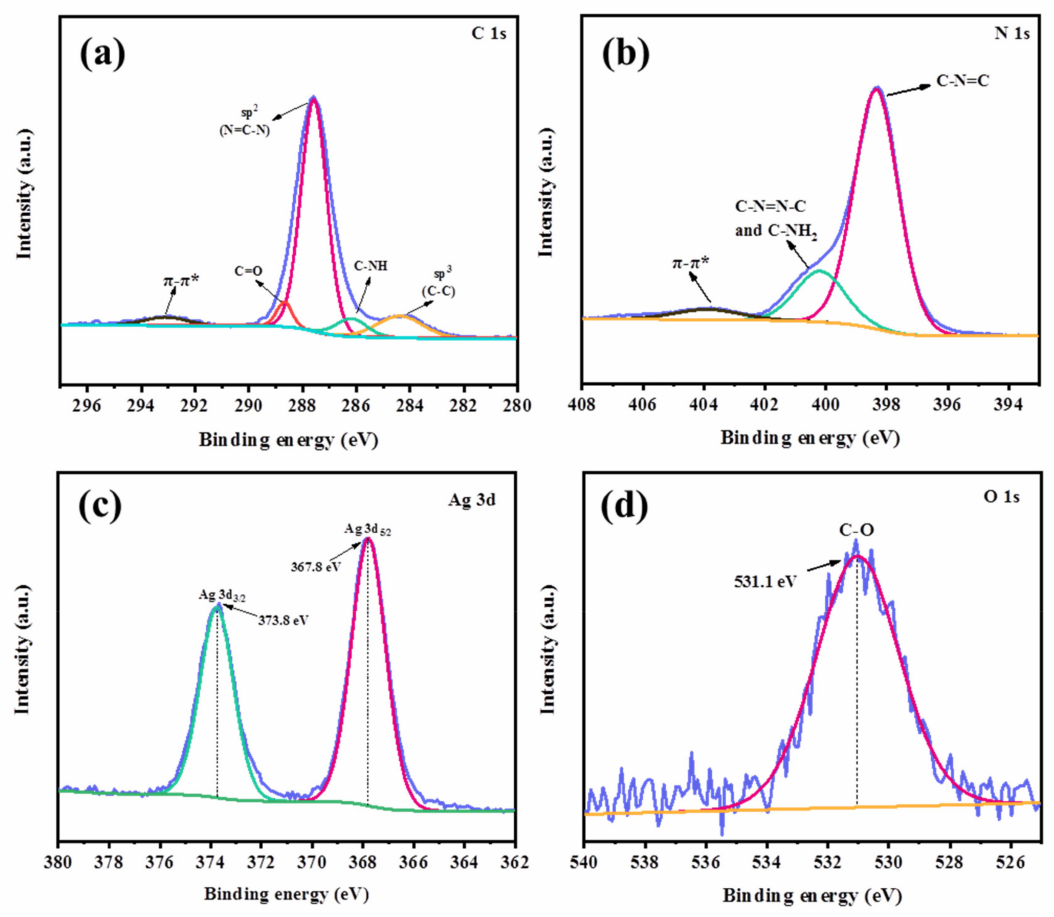
Figure 5. XPS spectra of CNAC-10, ( a ) C 1s, ( b ) N 1s, ( c ) Ag 3d, and ( d ) O